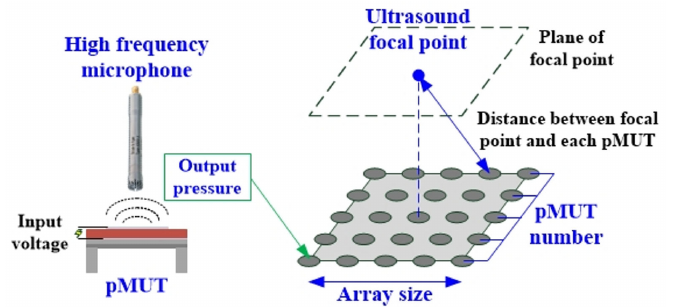
Figure 6. Structure of the sound pressure simulation for the pMUT array.